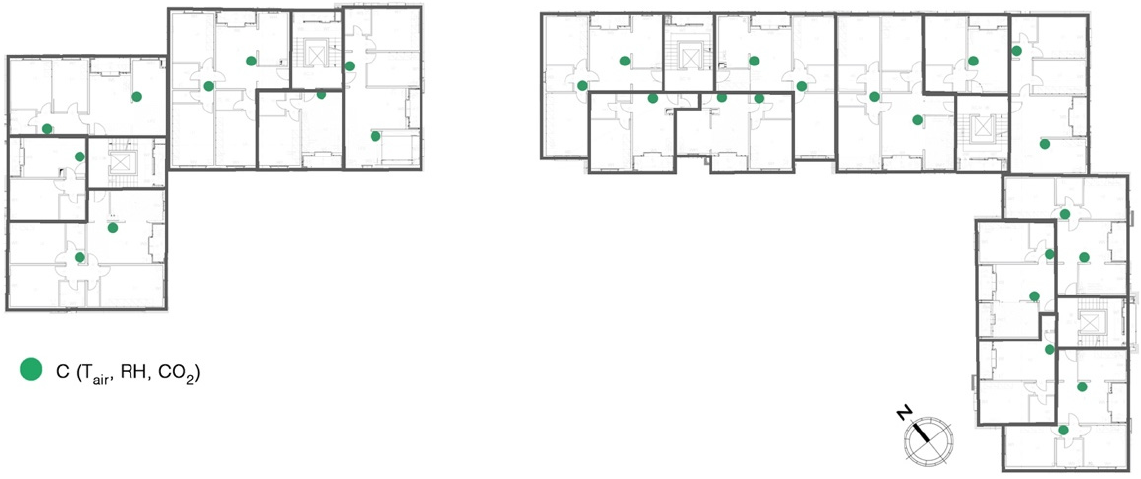
Figure 4. Air temperature sensors distribution in a floor type: one-bedroom apartments present one sensor, two or more room apartments present two sensors.